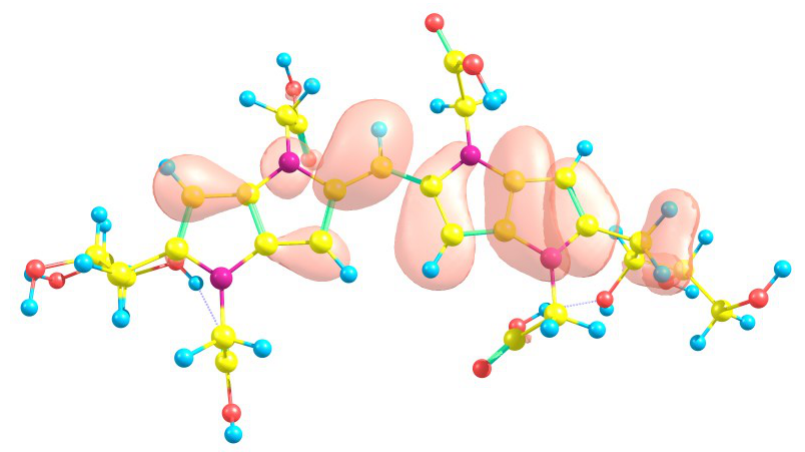
Figure 3. A graphical schematic representation of the radical Fukui function f 0 of the Blue-G1 intermediate melanoidin